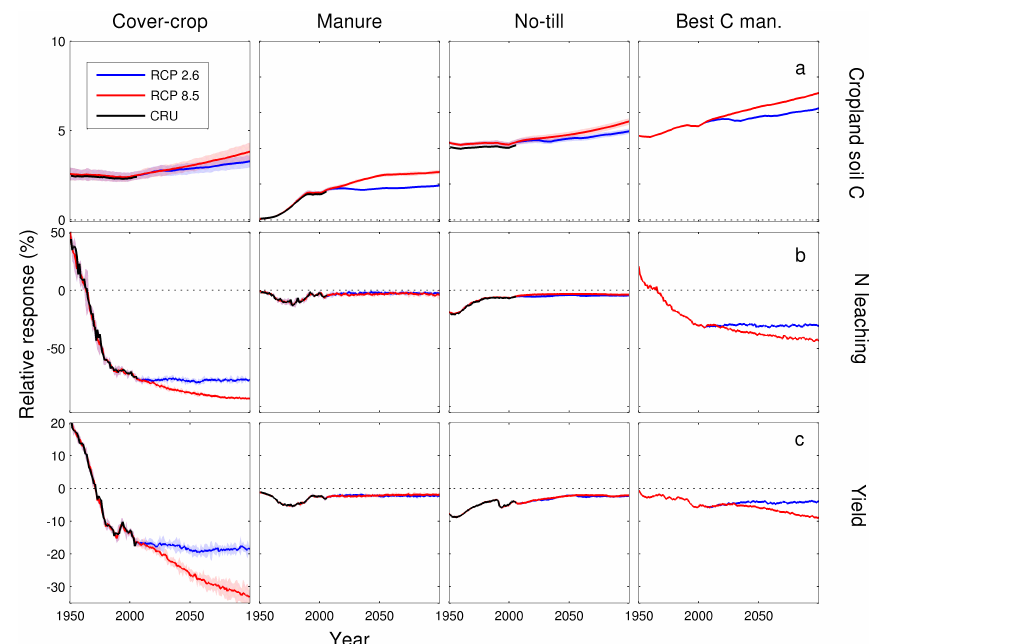
Figure 5. The simulated response on (a) global C in cropland soils, (b) yields and (c) N leaching with management options implemented in LPJ-GUESS relative to the standard set-up. The black line represents the response with historic climate (CRU); red and blue show the mean of simulations using four GCMs (described in Sect. 2.2) for RCPs2.6 and 8.5 respectively. Shaded areas show the mean ± 2SD. The panels on the right show the results from choosing the best SOC management compared to the standard for the two